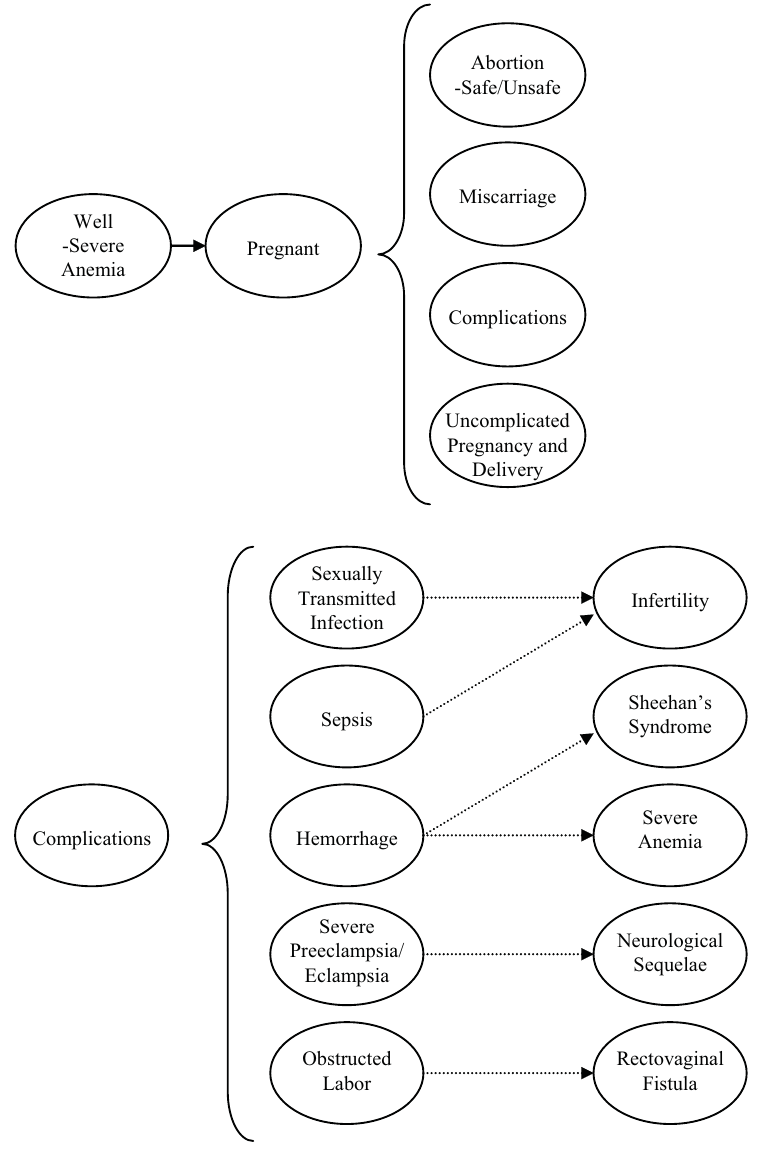
Figure 1. Schematic of Natural History Model. Upper Panel . The ovals represent the key health states used in the model. Nonpregnant 15-year-old women enter the model and are subject to an annual risk of pregnancy. Once pregnant, a woman may experience a miscarriage, elect to undergo an abortion, develop a maternal complication, or have an uncomplicated pregnancy and delivery. A small proportion of nonpregnant women will have severe anemia and subsequently will have a higher risk of mortality from maternal complications. Lower Panel . Every pregnant woman is subject to a risk of developing major maternal complications, such as a sexually transmitted infection with chlamydia or gonorrhea, sepsis, postpartum hemorrhage, severe preeclampsia/eclampsia, or obstructed labor. Each maternal complication is associated with a further risk of death or long-term sequelae (e.g., infertility, severe anemia, neurological sequelae, rectovaginal fistula), which are associated with a decrement in health-related quality of life and costs related to either management or